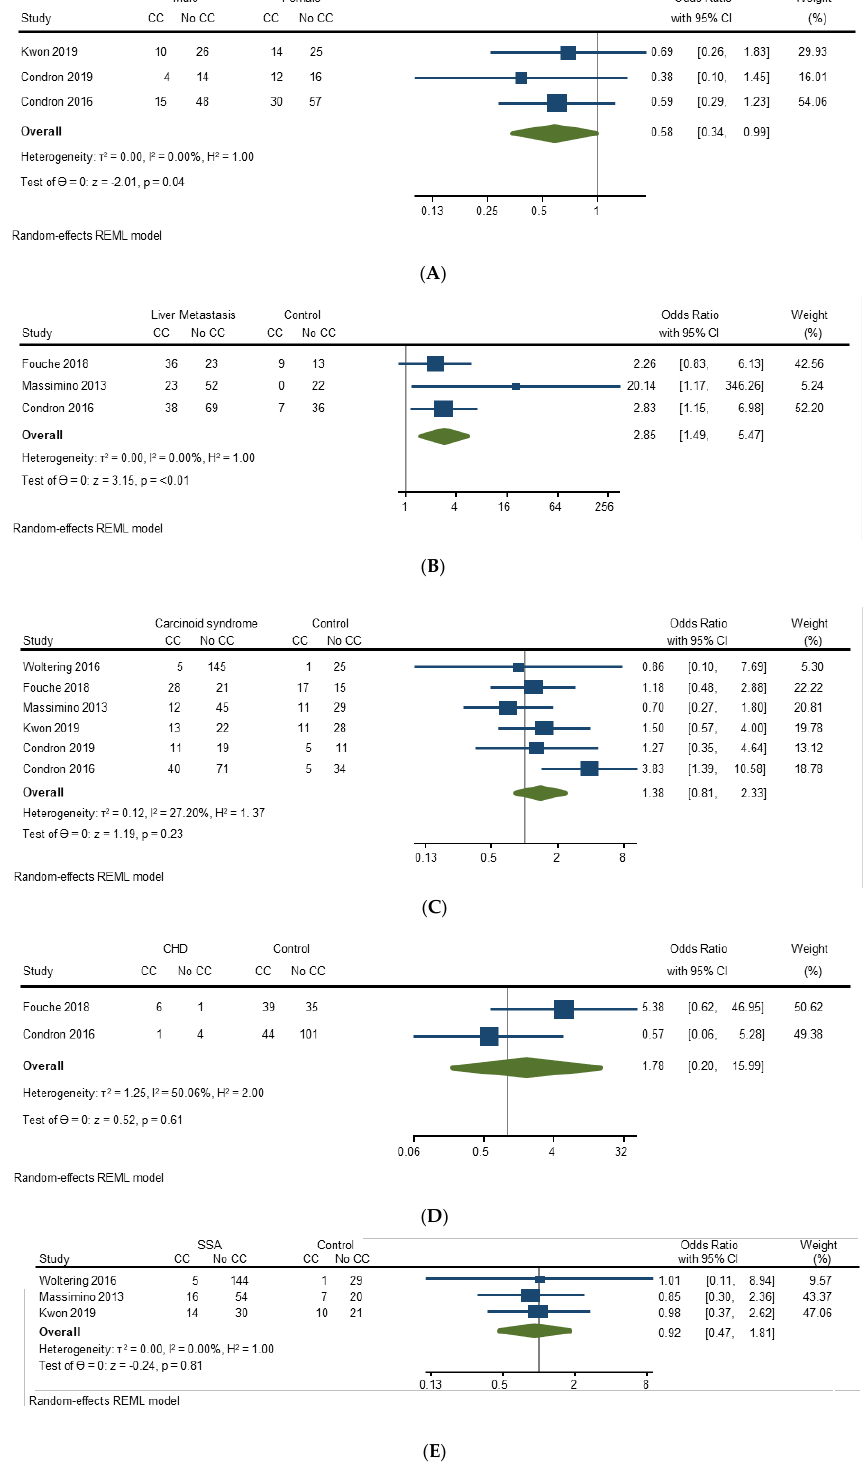
Figure 2. ( A ) Forest plot evaluating risk factors — gender; ( B ) Forest plot evaluating risk factors — liver metastasis; ( C ) Forest plot evaluating risk factors — carcinoid syndrome; ( D ) Forest plot evaluating risk factors — carcinoid heart disease (CHD); ( E ) Forest plot evaluating risk factors — long-acting somatostatin analogues [21 – 24,26,27].